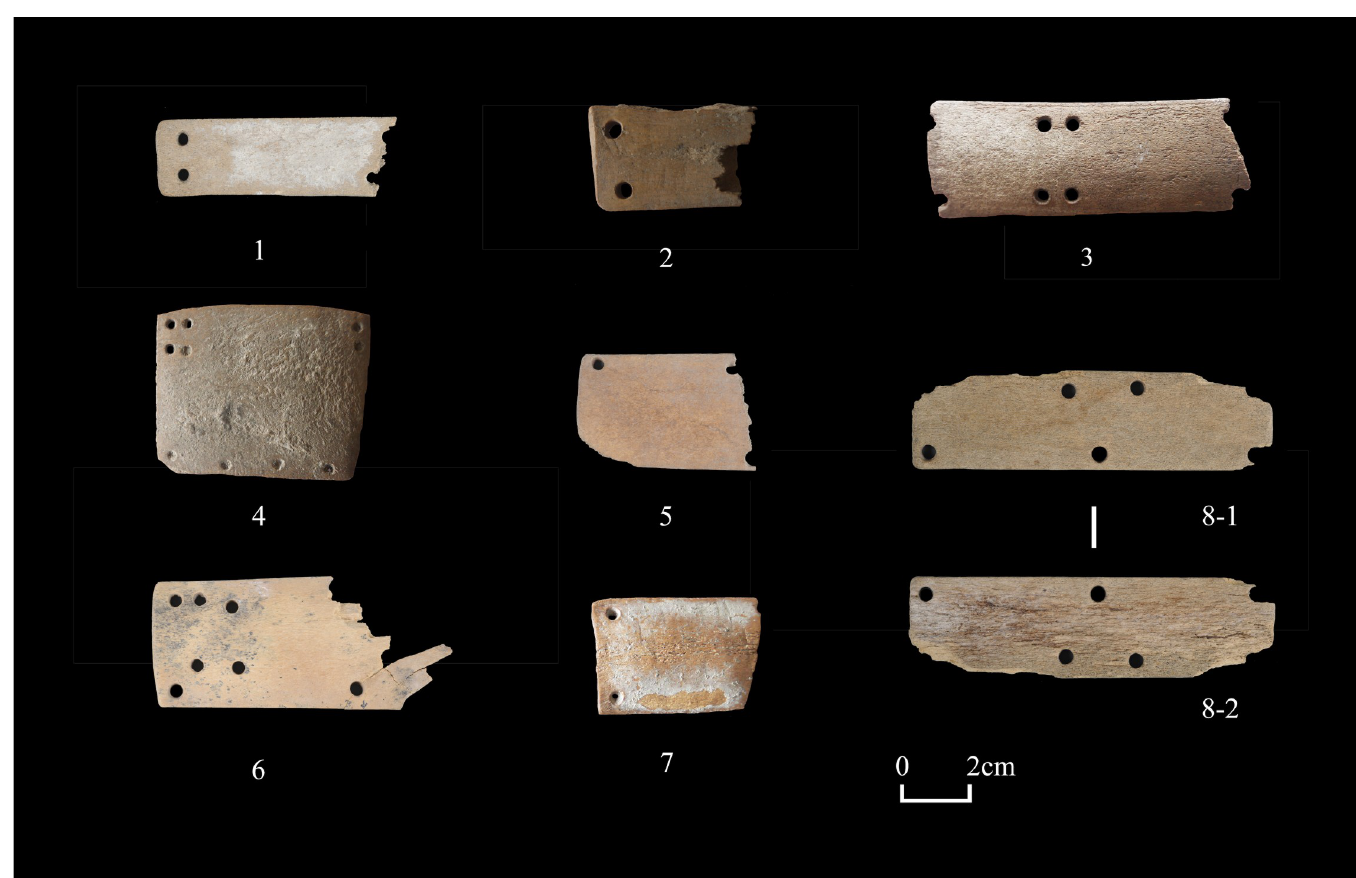
Fig 10. Examples of bone plates from Shirenzigou. 1) specimen from 2010HBSIIIT0620II ② ; 2) specimen from 12XBSIIIT0720IIIH025; 3) specimen from 12XBSIIIT0721II-2 ② ; 4) specimen from 12XBSIIIT0720IIIH020; 5) specimen from 2010HBSIIIT0620II ③ ; 6) specimen from 2010HBSIIIF004 ④ ; 7) specimen from 12XBSIIIF006; 8) specimen from 2010HBSIII-P2 ③